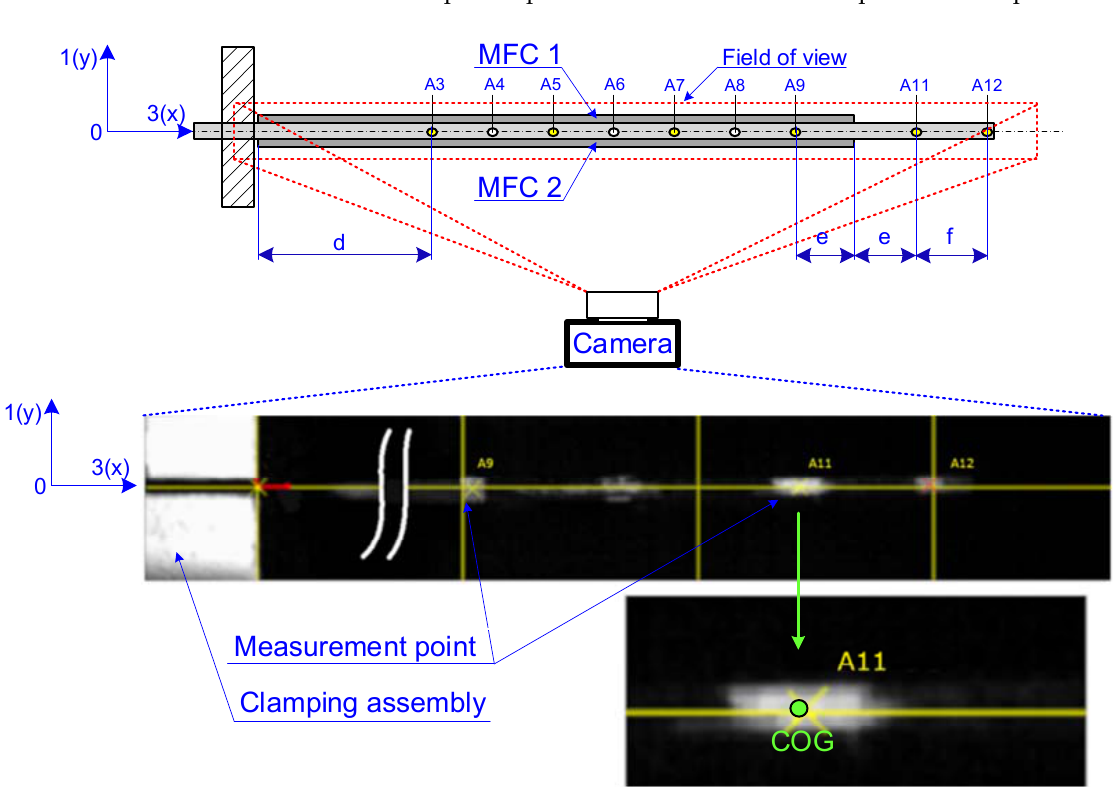
Figure 2. View of displacement of measurement points in a beam structure: d = 30 mm, e = 10 mm, f = 8 mm.